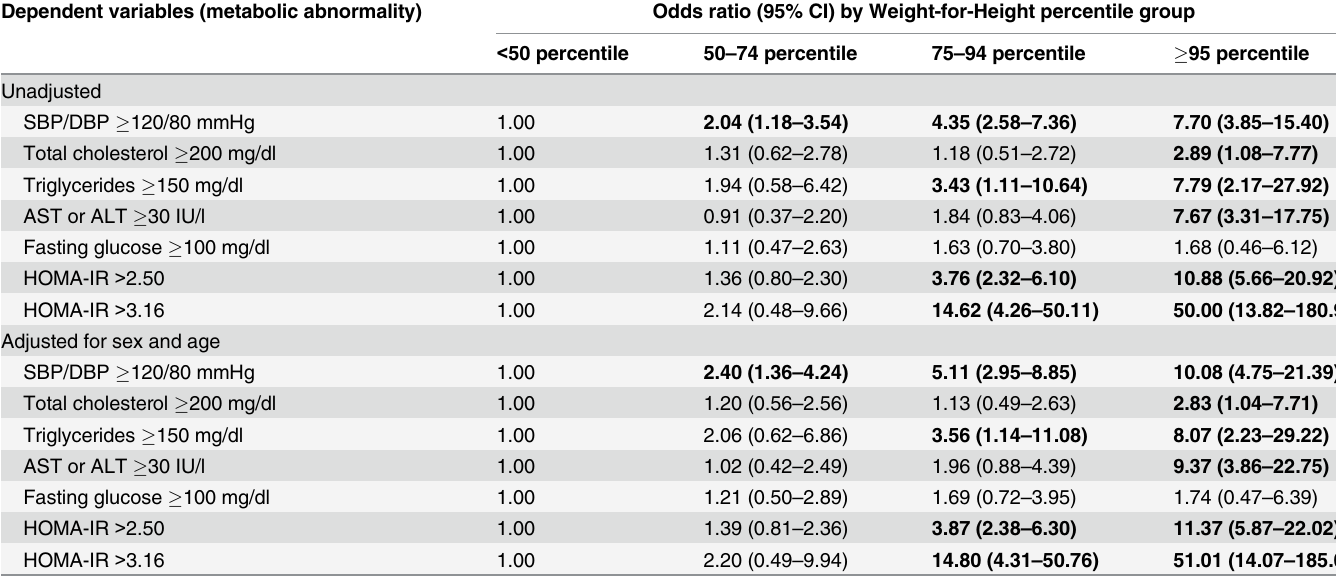
Table 3. Risk for Metabolic Abnormalities by Weight-for-Height